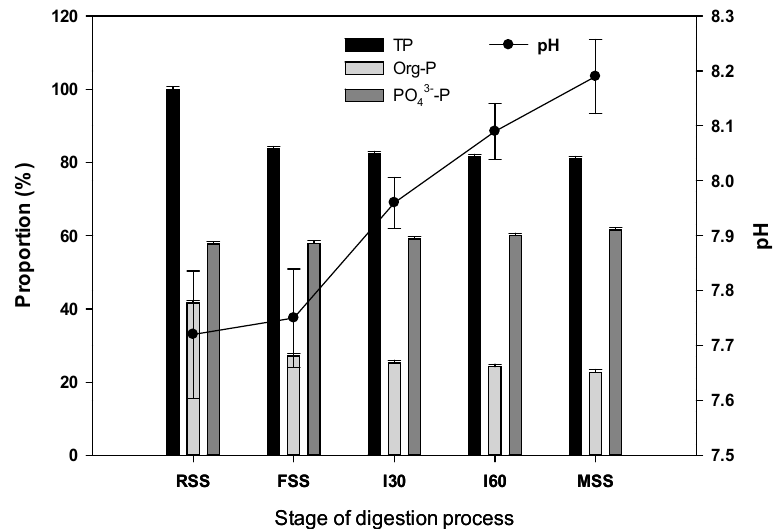
Figure 5. Changes in proportion of P content and pH corresponding to each digestion stage. TP, total phosphorus; Org-P, organic phosphorus; PO 4 3 − -P, phosphate. Error bars indicate standard error.